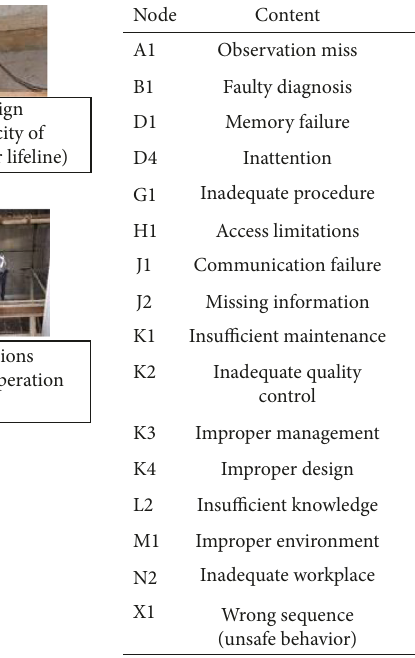
Figure 1: Human error model for construction industry using an elevator installation as an